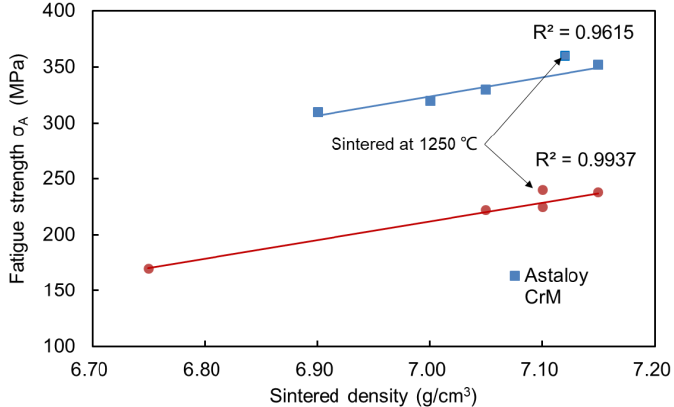
Figure 1. Fatigue endurance limit ( σ A ) of alloy steels as a function of density. The alloy steels were sintered at 1120 °C, then cooled at 2 – 3 °C/s (for Astaloy CrM), or naturally cooled (for Distaloy AE).